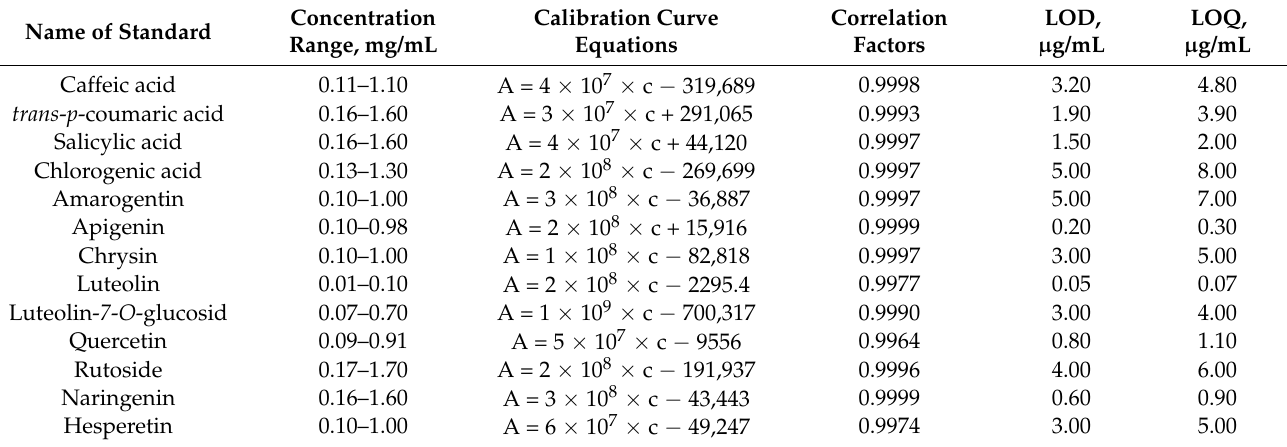
Table 8. LC-MS standards quantification